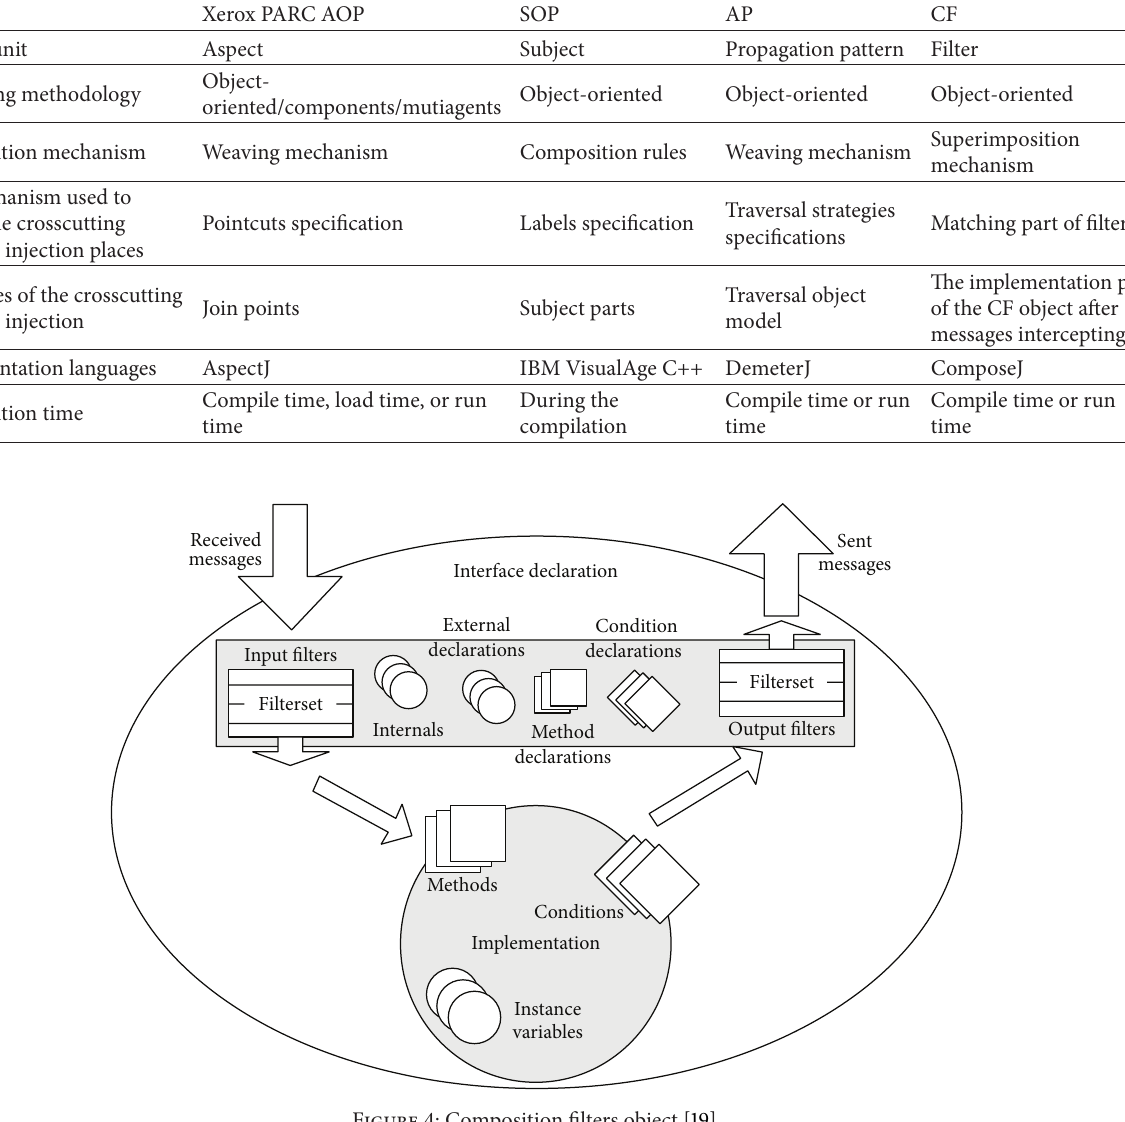
Table 1: Comparison between AOP approaches.